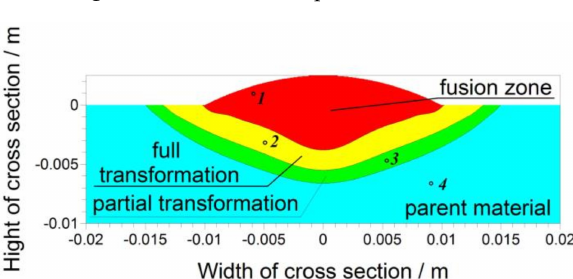
Figure 7. Cross section with determined heat a ff ected zone.